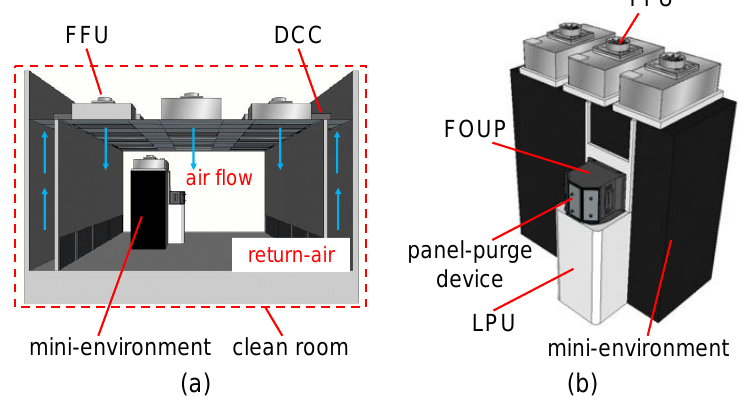
Figure 1. Testing environment of the present study: ( a ) ISO Class-6 clean room and ( b ) ISO Class-2 mini-environment. FFU—fan filter units; DCC—dry cooling coil; FOUP—front opening unified pod; LPU—load port unit.